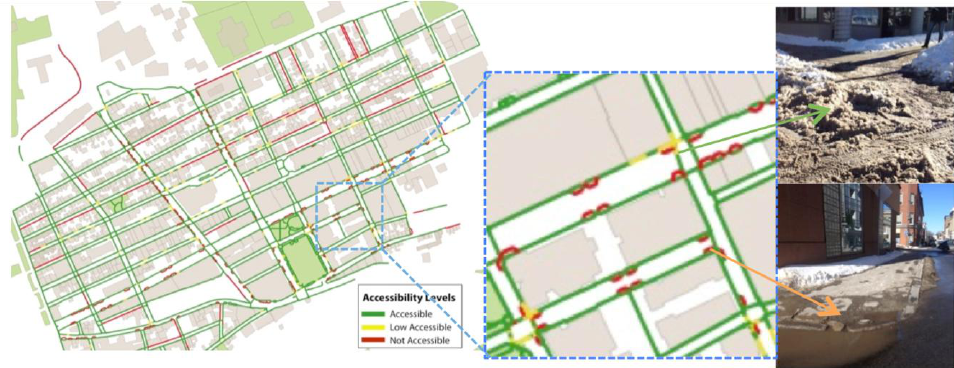
Figure 6. The accessibility condition of the curb cuts in the study area.